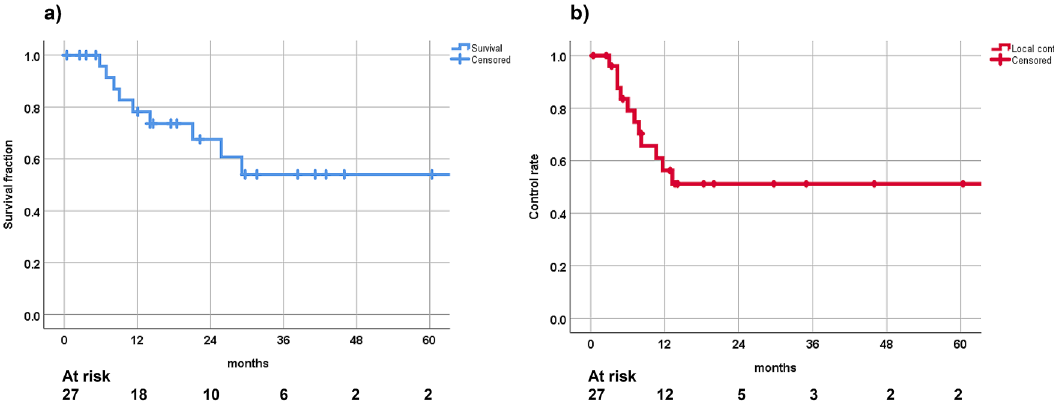
Figure 2. ( a ) Overall survival and ( b ) local control rate after the 2nd